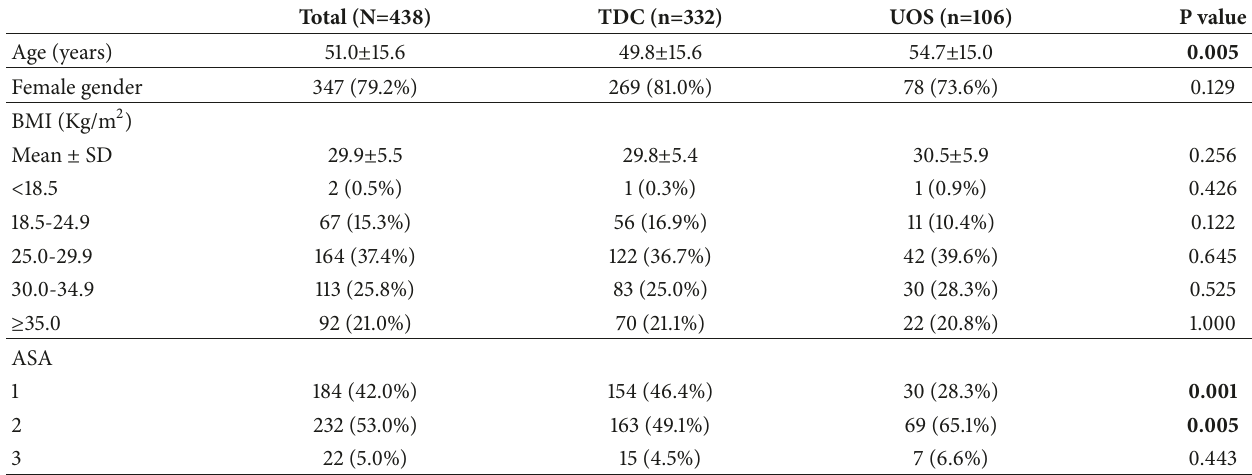
Table 1: Patient demographics: TDC versus UOS.